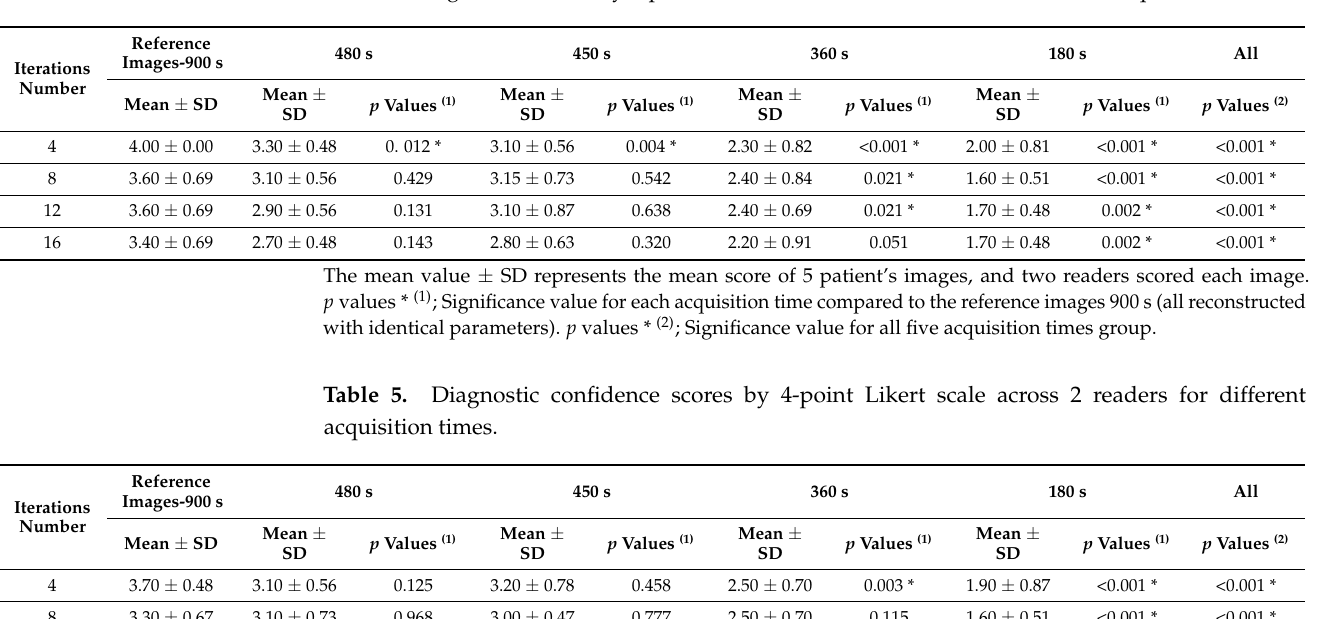
Table 4. Image noise scores by 4-point Likert scale across 2 readers for different acquisition times.